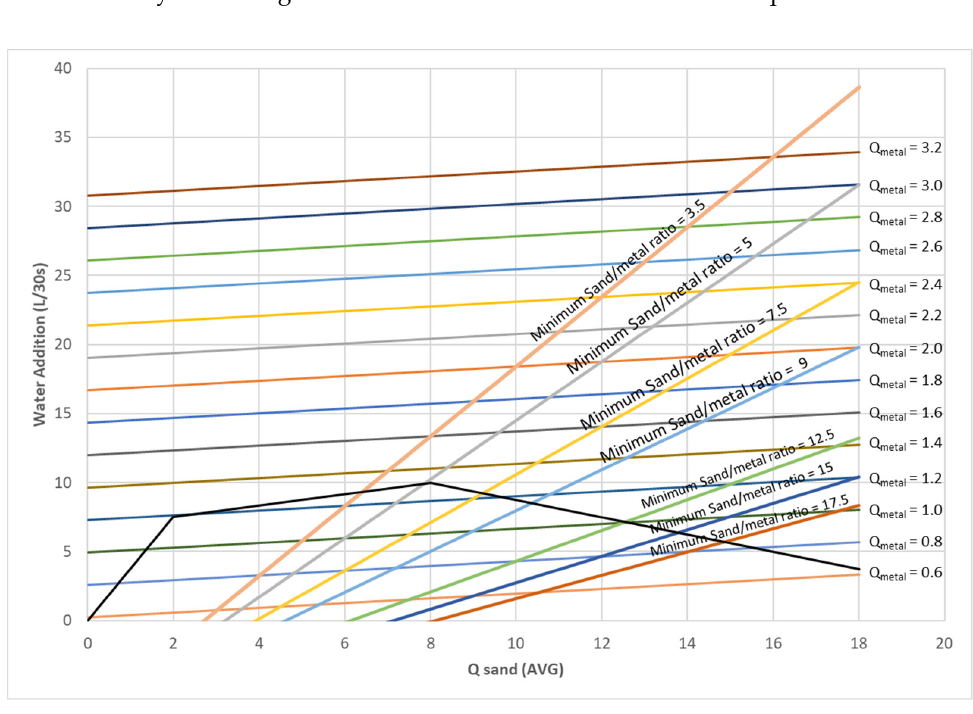
Figure 7. Ratio of sand and metal flows with respect to the proposed addition of water. The addition of water is related to the sand/metal ratio of the molds. The black lines show the minimum water additions.